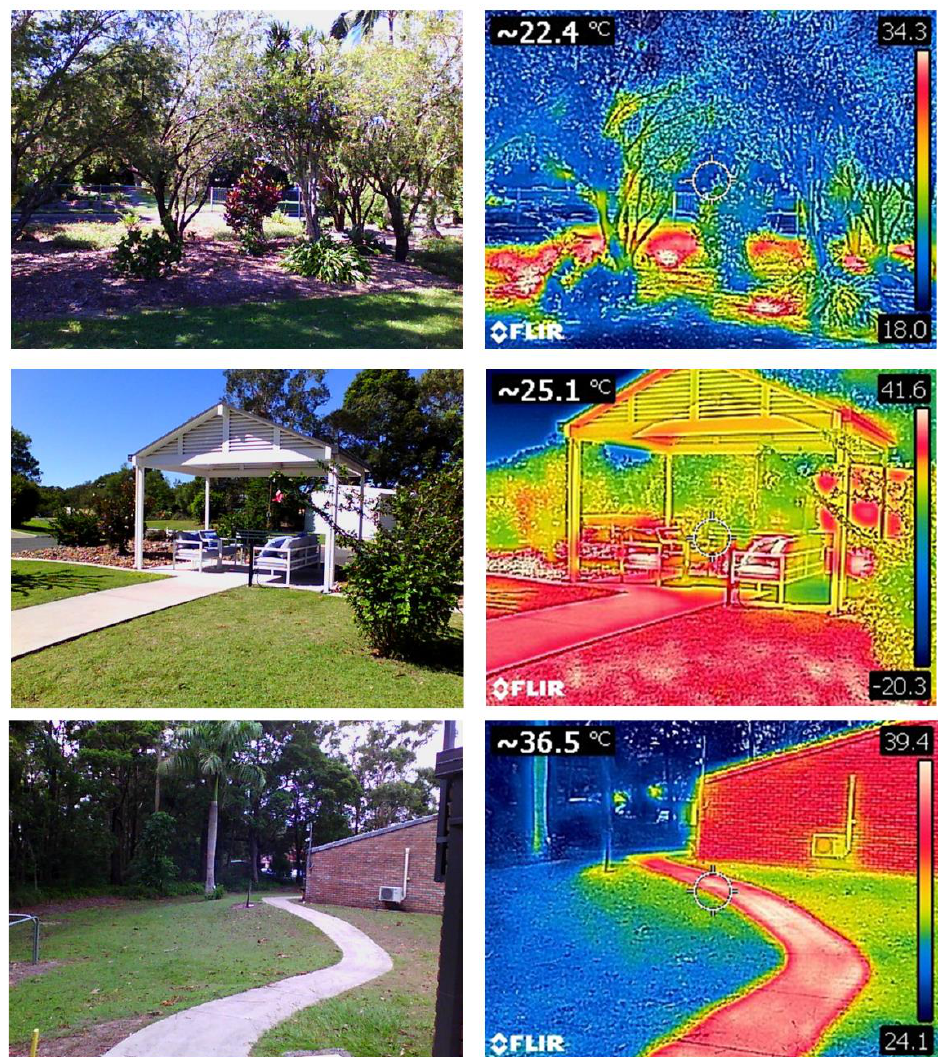
Figure 6. Thermal images and corresponding site photos for Caloundra ACF in sectors C4 ( top ), C3 ( center ), and C1 ( bottom ). Thermal images were taken in the summer (28 January 2021) between 2:00 p.m. and 3:30 p.m. (Image Source: Author). Refer to Supplementary Materials for additional